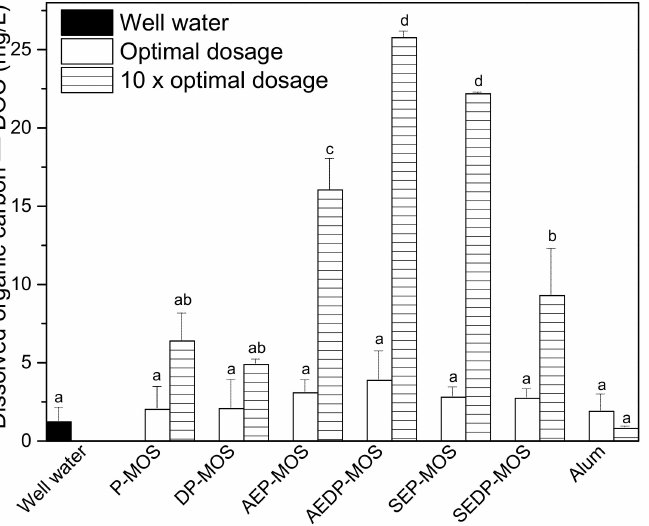
Figure 6. Dissolved organic carbon (DOC) variation as a function of Moringa oleifera seed-derived and alum coagulants dosages (optimal dosage and 10 × optimal dosage) in jar tests after coagulation, flocculation, and sedimentation. Bars with the same letter represent means that did not differ significantly ( p ≤ 0.05) based on Tukey HSD post hoc